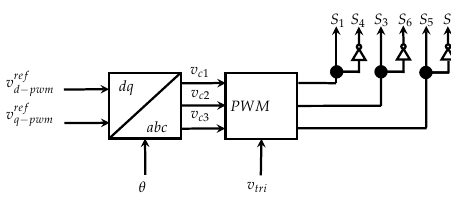
Figure 7. PWM generation scheme using dq transformation.